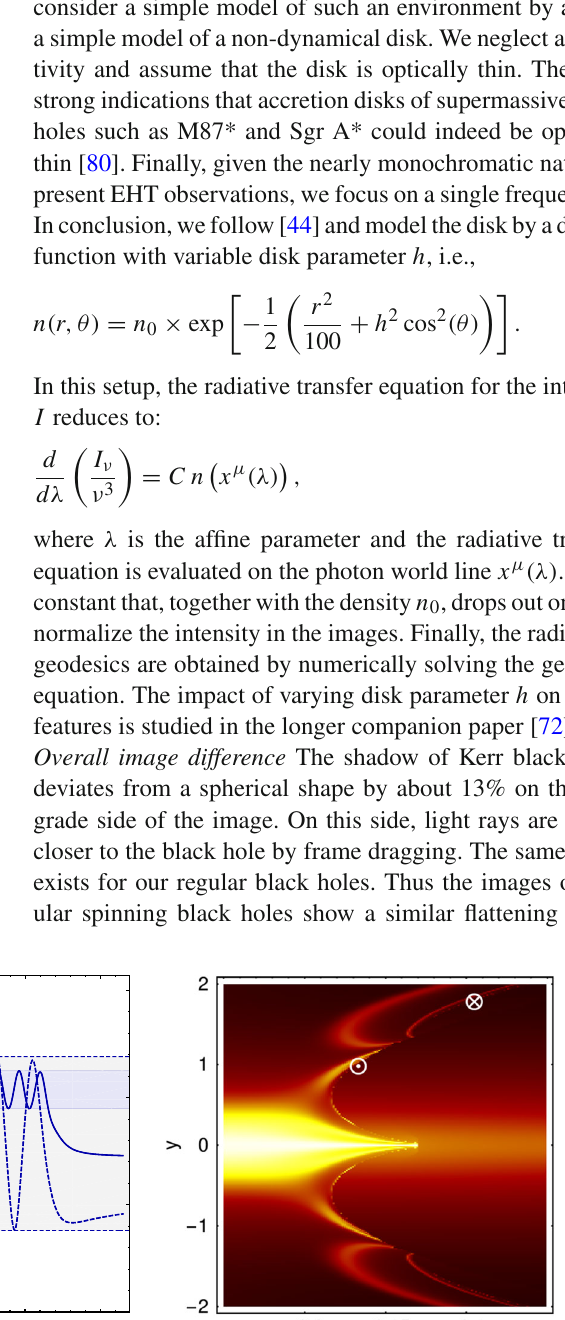
metric (continuous) sections of the spacetime. Right-hand panel: The resulting intensity image (normalized to the brightest image point) for inclination θ obs = π/ 2. Cusps in the shadow boundary occur whenever trajectories jump between symmetric and asymmetric θ -oscillations (cf. middle